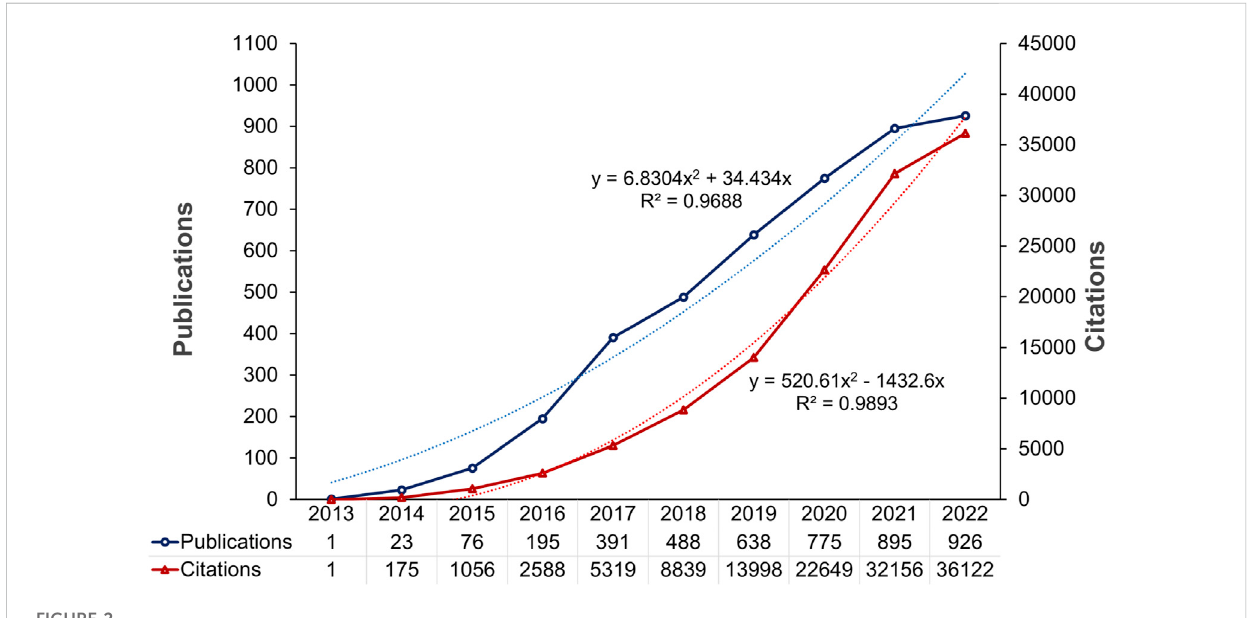
FIGURE 2 Annual trends in publications and citations on CRISPR in cancer from 2013 to 2022.